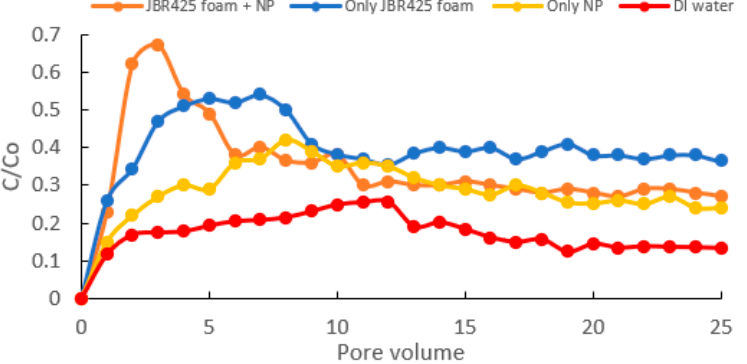
Figure 7. Oil treatment rate (C/Co) in column experiments using JBR425 rhamnolipid biosurfactant foam and Fe/Cu nanoparticles (NP) under various conditions.